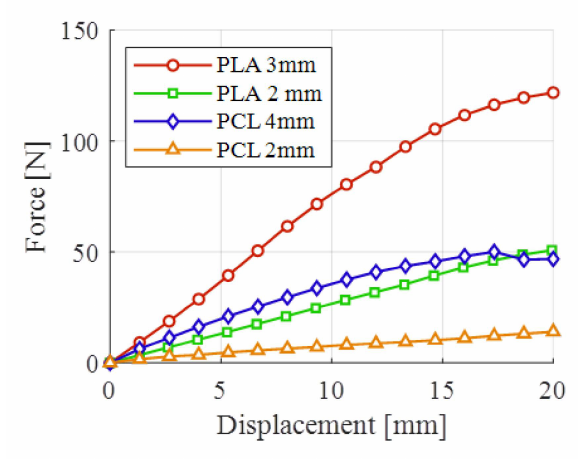
Figure 13. Bending tests results of semi-orthosis configurations.